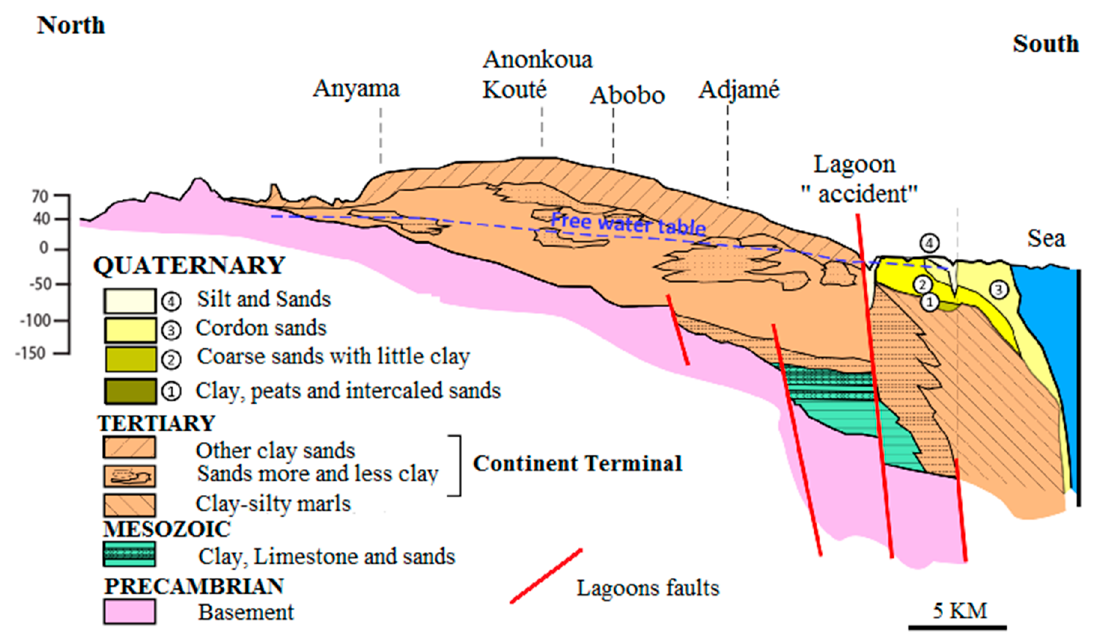
Figure 2. Geological formations of the coastal sedimentary basin in Abidjan (based on [24]).